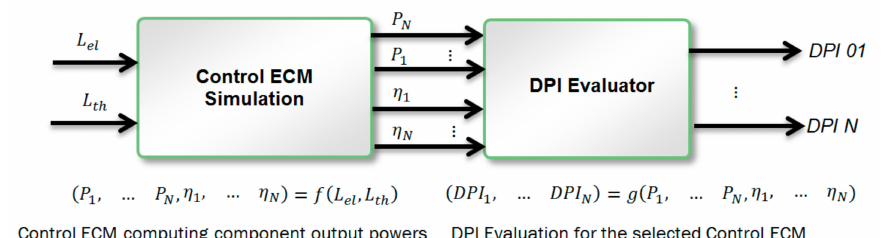
Figure 6. Control ECMs simulation and DPI